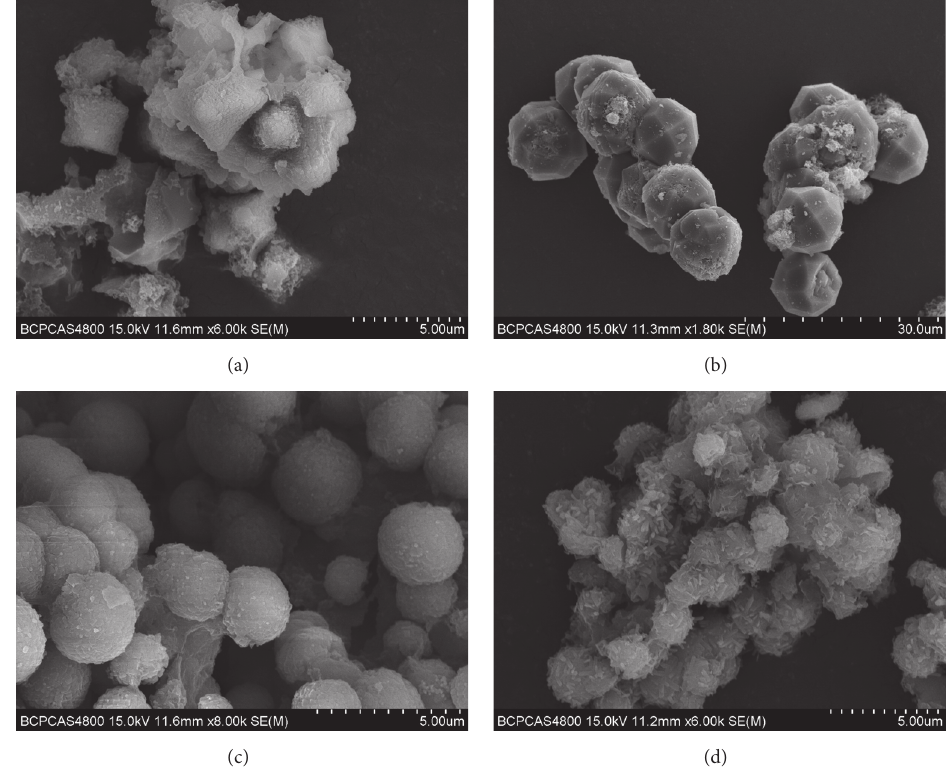
Figure 4: SEM images of samples prepared at different NaOH concentrations: (a) 0.0 mol/L, (b) 0.5 mol/L, (c) 1.0 mol/L, and (d) 1.5mol/L.